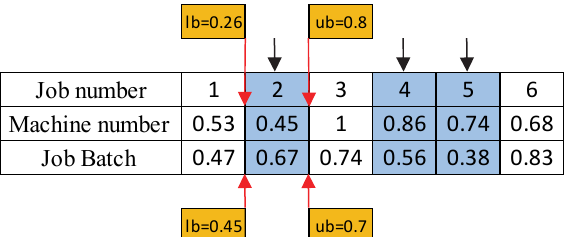
Fig. 4 Random selection of genes and performing a mutation operator on them and new genes generated by random numbers in created intervals